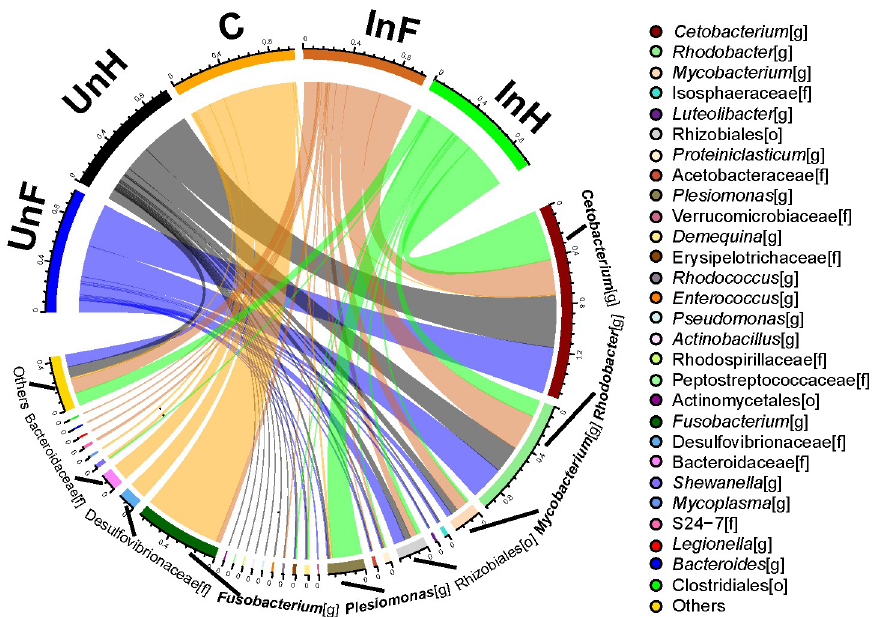
Fig 2. Microbiota composition in the foregut and hindgut of grass carp and on S . acheilognathi surface at the genus level. UnF, uninfected with S . acheilognathi in foregut of grass carp; UnH, uninfected with S . acheilognathi in the hindgut of grass carp; C, the surface of S . acheilognathi ; InF, infected with S . acheilognathi in the foregut of grass carp; InH, infected with S . acheilognathi in the hindgut of grass carp; Others: the sum of different taxa with an abundance less than 0.5% in the